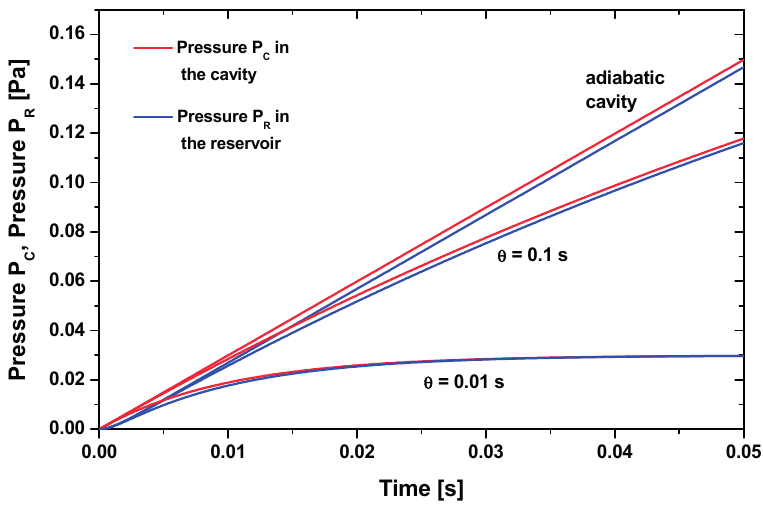
Figure 8. Model of the sensillum with nanocanals ( left ) and Model of the IR sensor ( right ) with cavity (pressure P C , volume V C ) and reservoir (pressure P R , volume V R ). The canal of the compensation leak has a radius R L and a length L.